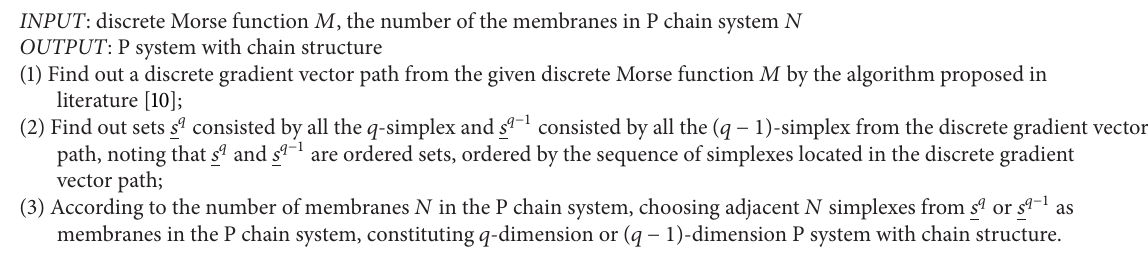
Algorithm 1: Construction algorithm of P system with chain